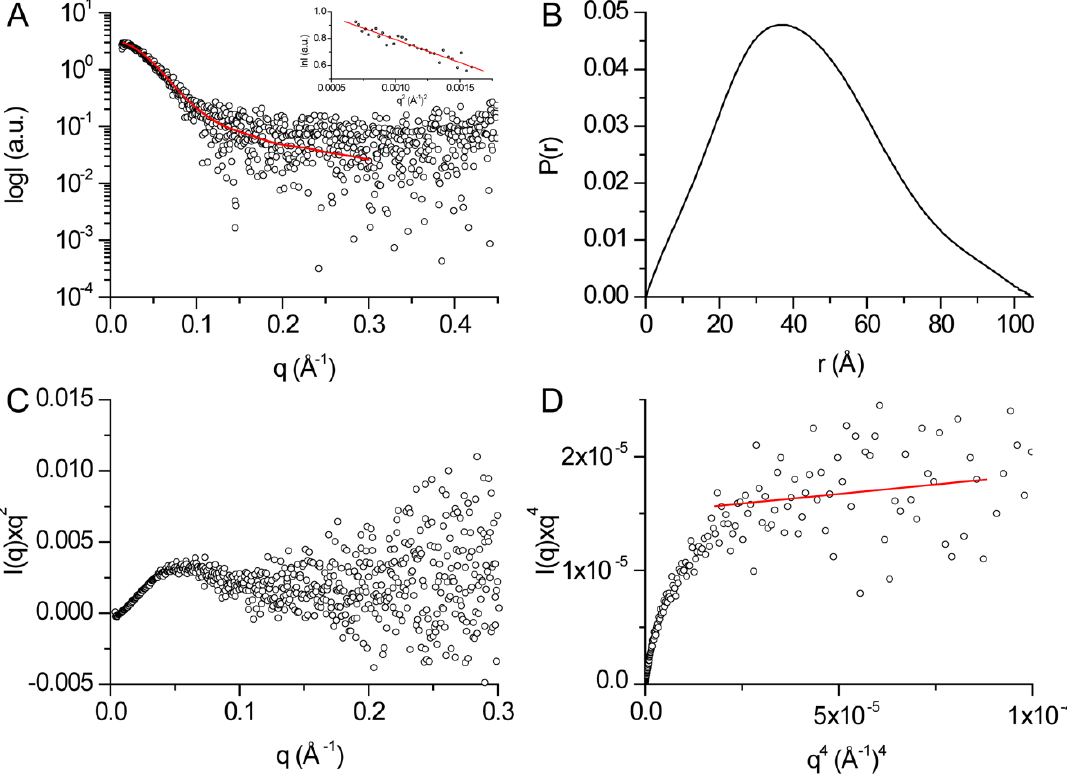
Figure 4. SAXS analysis of purified human DHDDS. ( A ) Experimental SAXS curves of human DHDDS (circles) along with the fit obtained by GNOM (red line). Inset: Guinier analysis. ( B ) Paired- distance distribution function of human DHDDS determined using GNOM. ( C ) Kratky plot analysis. ( D ) Porod – Debye plot. The red line represents the fit used to determine the Porod exponent.